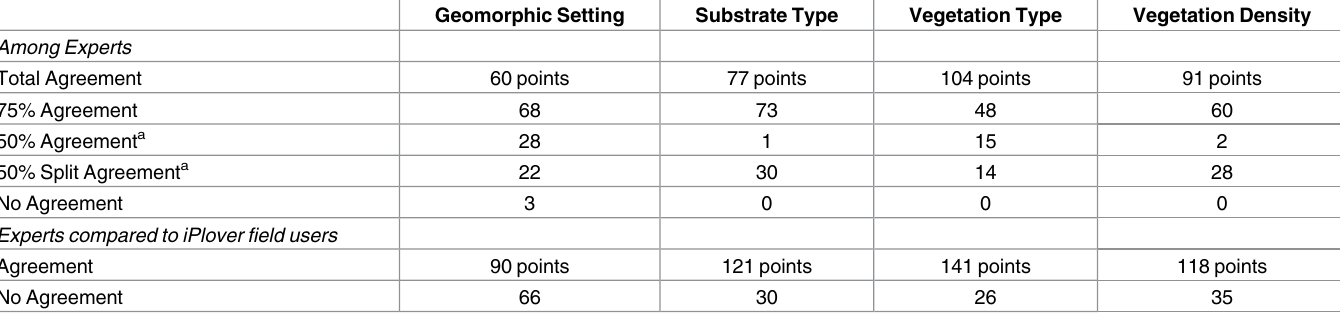
Table 2. Classification agreement for the habitat variables considered among four subject-matter experts and between experts and iPlover field users for 181 test points in the iPlover dataset (10% of the full dataset of 1799 data points). Geomorphic Setting Substrate Type Vegetation